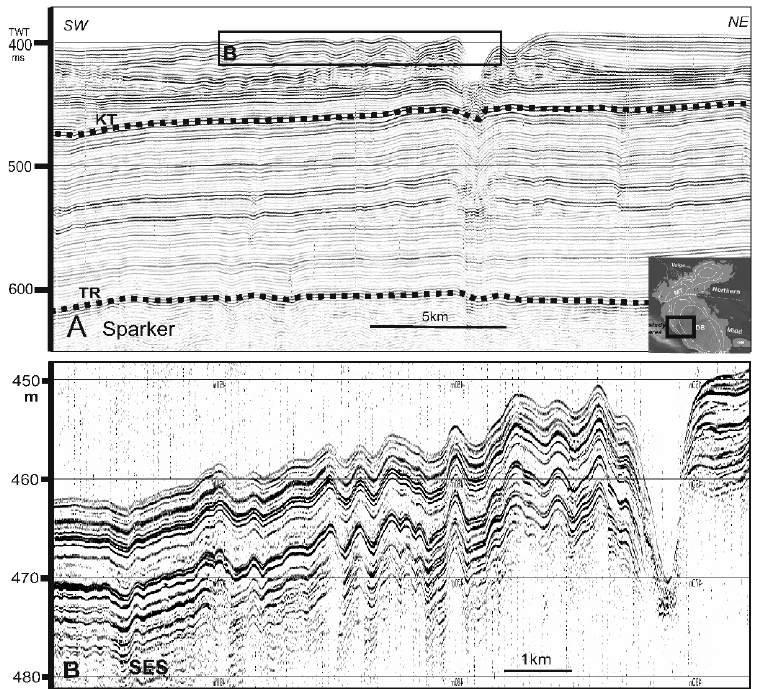
Figure 9. Sediment waves type 2 (on channel levees) on the northern slope of the Derbent Basin near the Mangyshlak Sill. ( A ) Fragment of the profile (sparker) SW-NE trending along foot of the slope. Main unconformities: TR—Turkanian regression, KT—Khvalinian transgression. ( B ) En- larged fragment of ultra–high-resolution seismic reflection profile (SES) showing in detail uppermost sedimentary layer. Location of the profiles is shown in Figures 2 and 8.